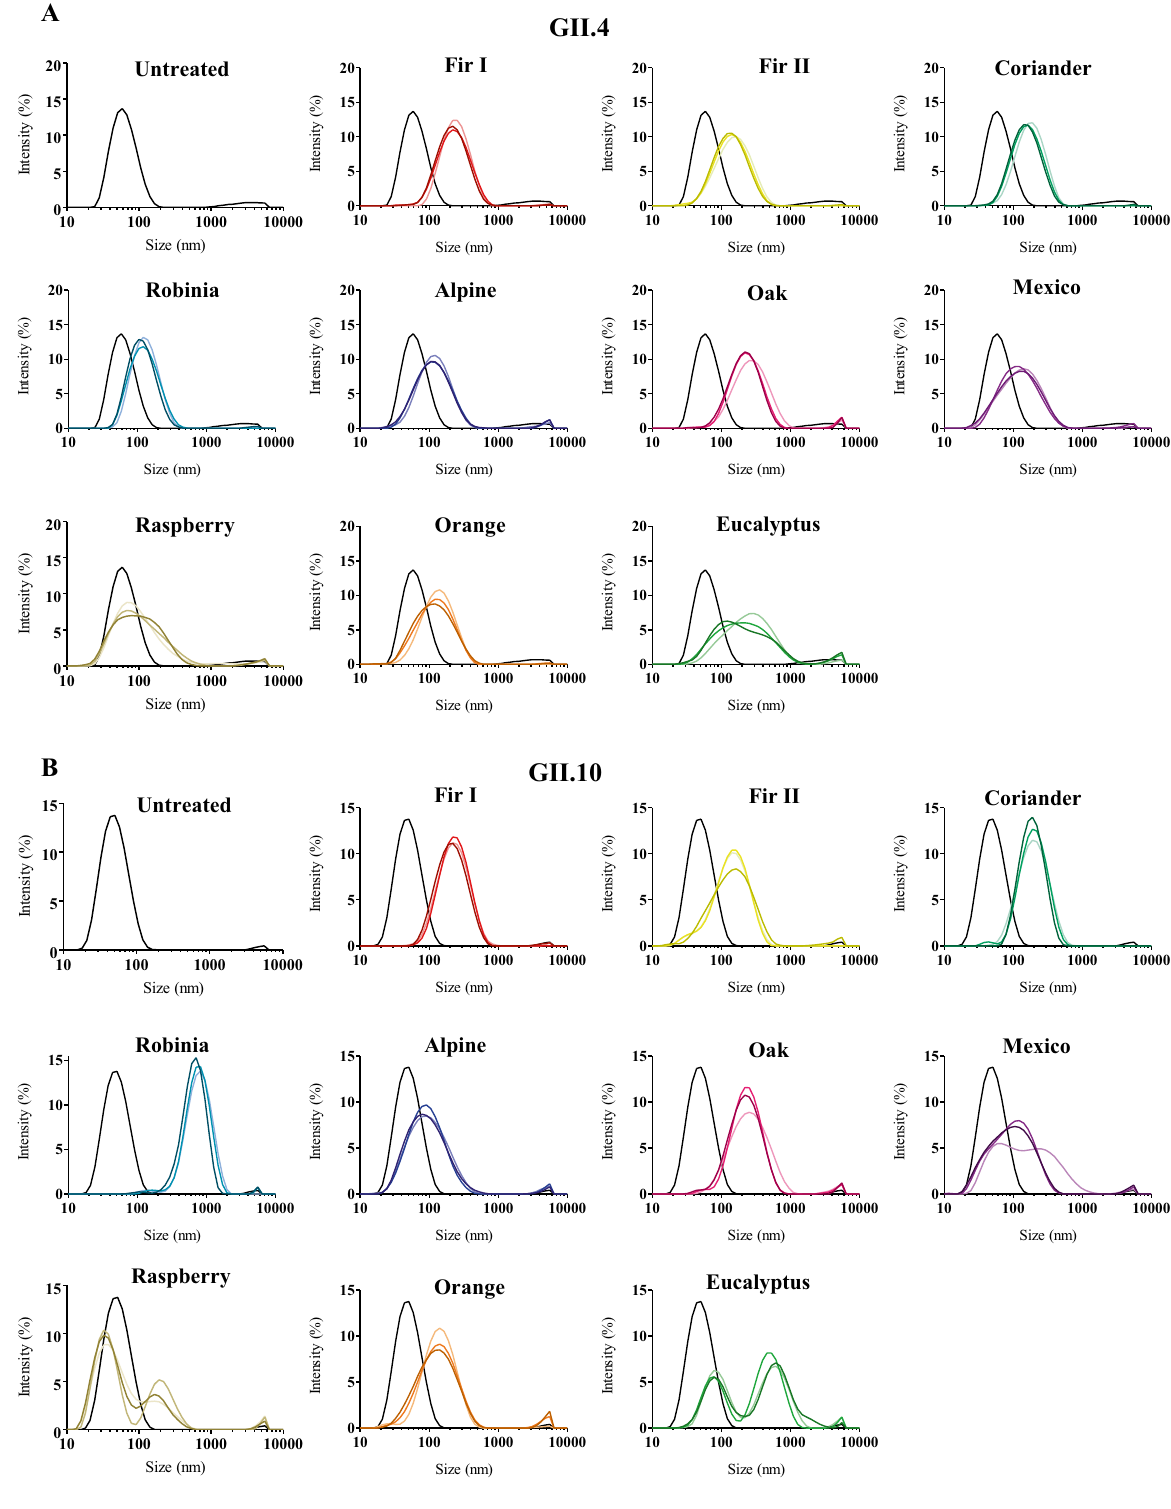
Figure 5. Honey samples and DLS measurements of GII.4 and GII.10 VLPs. DLS was used to evaluate the hydrodynamic size of VLPs (final concentration of honey 12.5%) at 10, 60, and 120 min (represented by light, medium and dark colored lines, respectively). For all honey samples, there was an increase in VLP diameters. ( A ) For treatment of GII.4 VLPs with fir I, fir II, coriander, Robinia, Alpine forest, Oak tree, Mexico, and orange blossom similar peak shifts were observed. Eucalyptus and raspberry treatment resulted in a flattened peak and a greater range of differently sized GII.4 VLPs aggregates. ( B ) For treatment of GII.10 VLPs, a similar pattern was observed as GII.4 VLPs, except that raspberry and eucalyptus treated GII.10 VLPs produced two peaks of increased sizes. Each experiment was performed in triplicate and representative measurements were